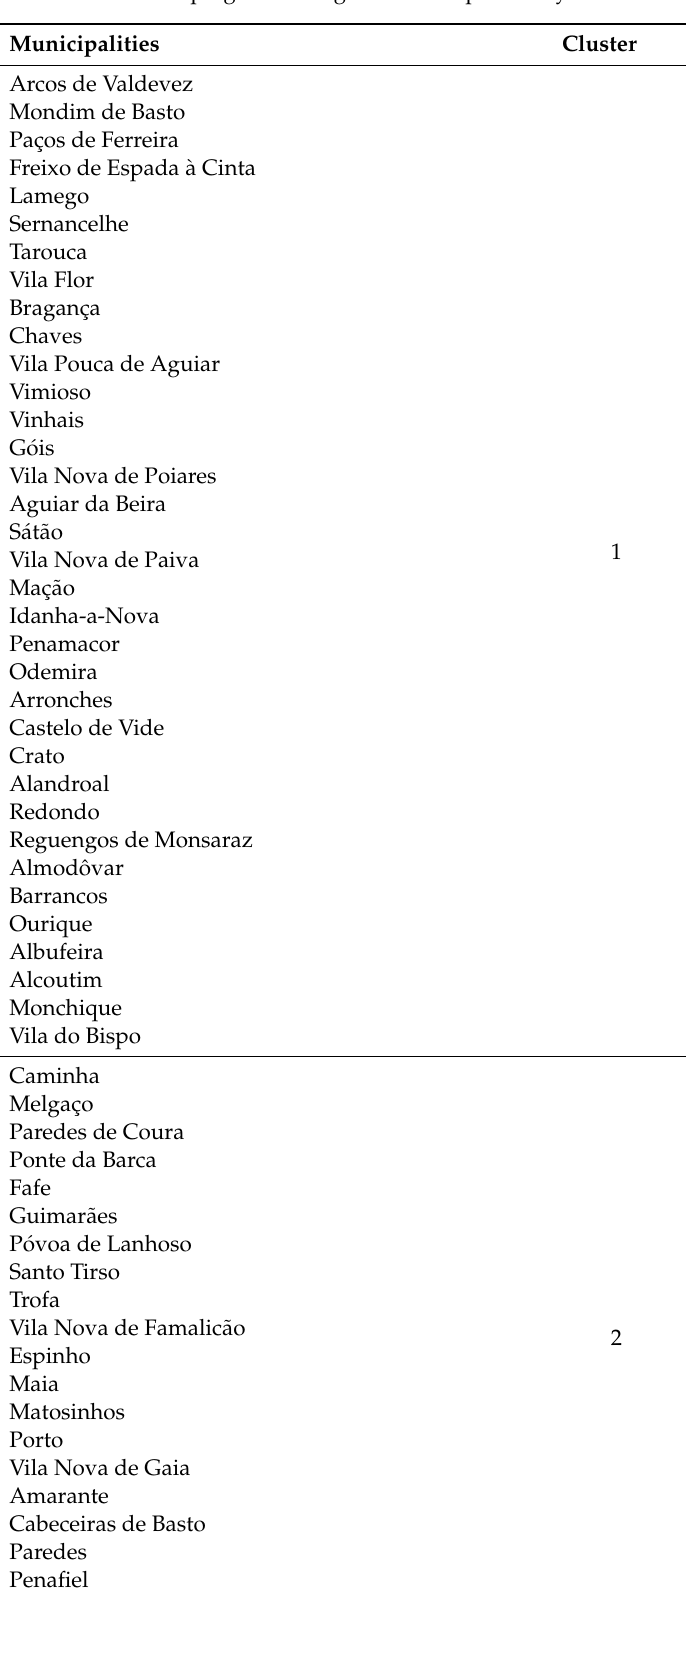
Table A1. Grouping the Portuguese municipalities by